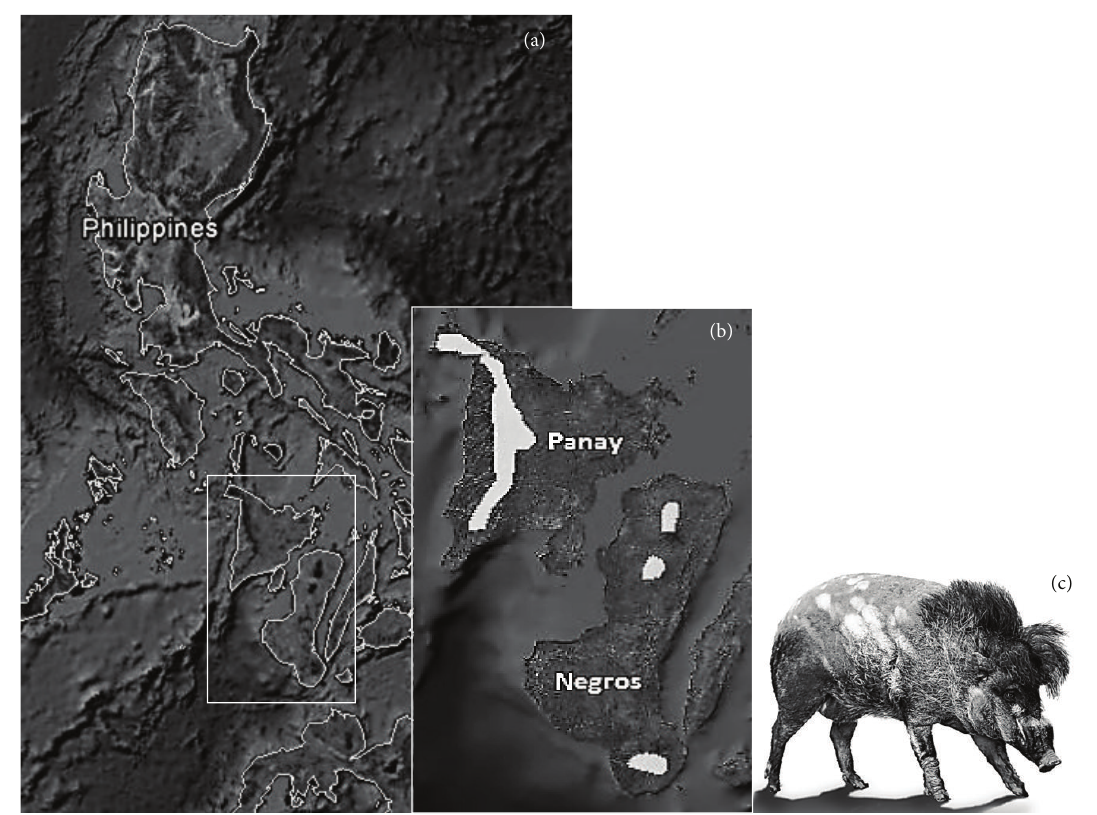
Figure 1: (a) Location of the islands Negros and Panay within the Philippine archipelago. At its smallest point the Guimaras Strait between them is 10 km wide. (b) Negros and Panay with the range of Sus cebifrons indicated in light-grey [4]. (c) Sus cebifrons individual (DVDW